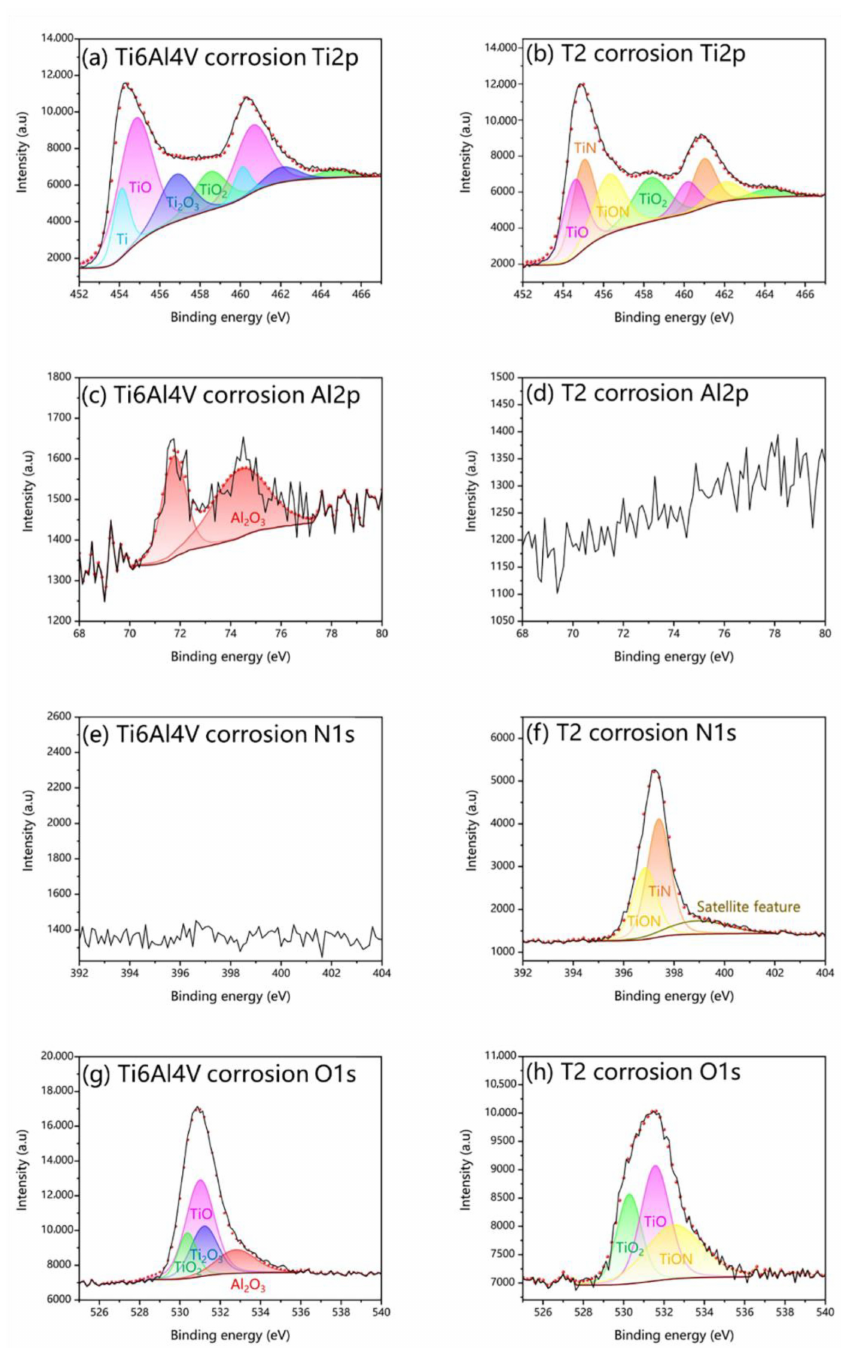
Figure 11. The XPS images after corrosion of untreated Ti6Al4V: ( a ) Ti 2p, ( c ) Al 2p, ( e ) N 1s, ( g ) O 1s; and T2 samples: ( b ) Ti 2p, ( d ) Al 2p, ( f ) N 1s, ( h ) O